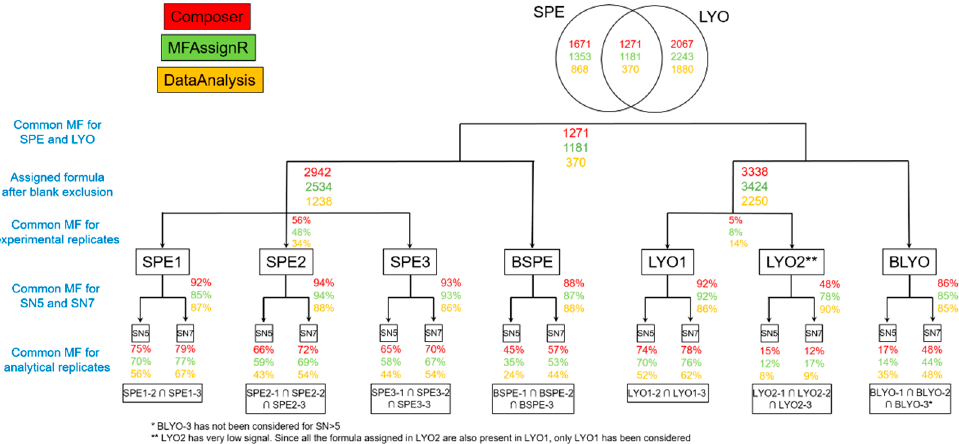
Figure 3. Percentage of MFs (molecular formulas) in common for each sample, considering only the number of MFs (percentage in number). Colors represent the data treatment applied for the three software programs considered in this work: red for Composer, green for MFAssignR, and yellow for DataAnalysis. The percentages in the first bottom line represent the common MFs for analytical replicates; those in the second line represent the common MFs for the S/N 5 (signal to noise) and S/N 7 ratios; and those in the third line represent the common MFs for the experimental replicates. The fourth line reports the number of MFs obtained after the exclusion of blank MFs, while the fifth line presents a comparison between SPE and LYO.